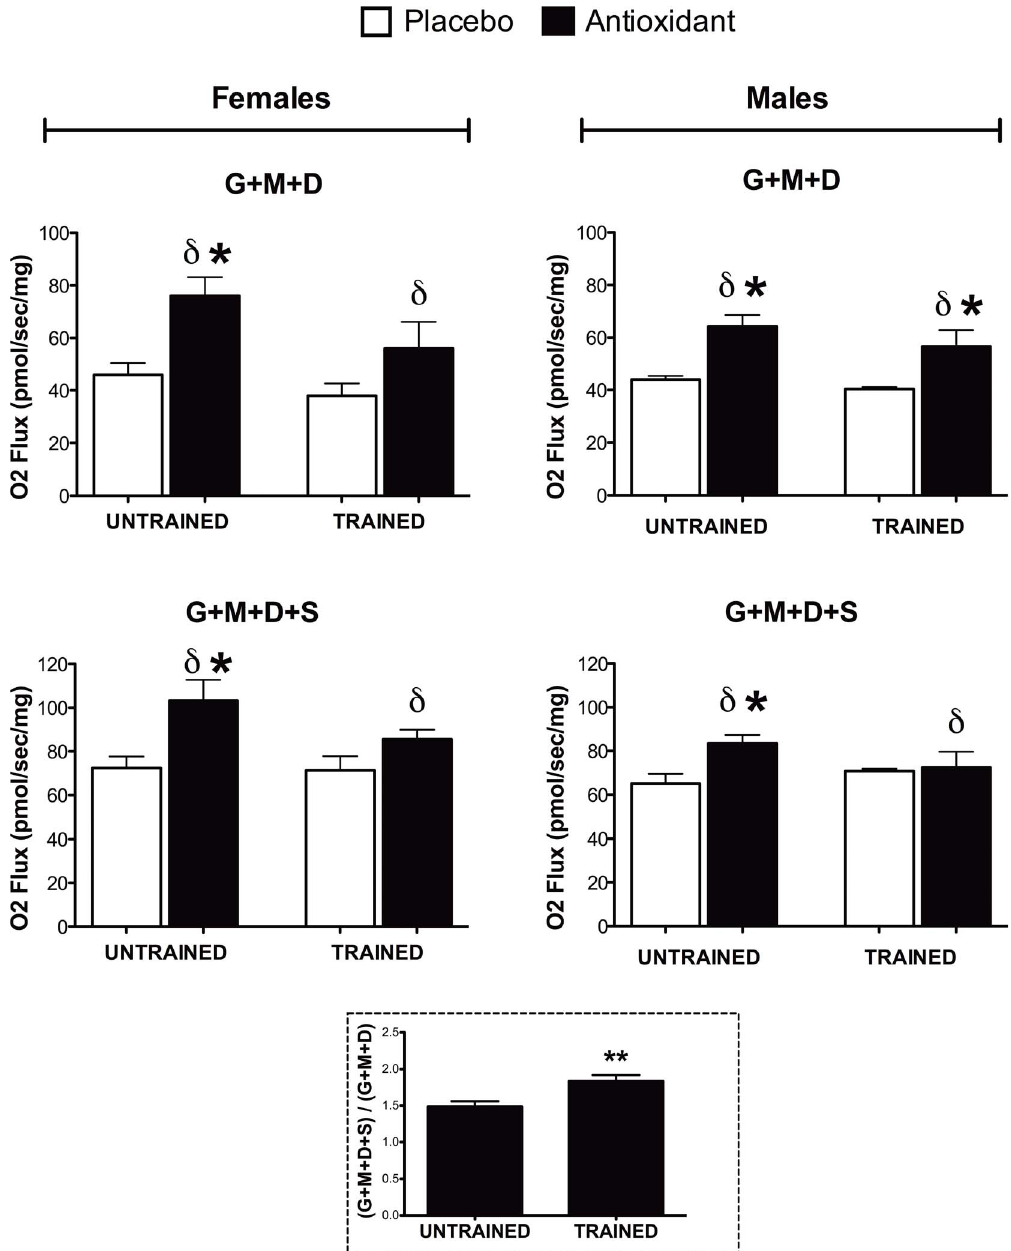
Figure 2. Mitochondrial respiratory capacity. Respiratory capacity was assessed in permeabilized fibers from quadriceps femoris muscle tissue (n=3–4). Maximal coupled respiration was measured in the presence of complex I substrates (glutamate and malate) and ADP (G + M + D, upper panels) followed by addition of the complex II substrate succinate to measure maximal coupled respiration through both complex I + II (G + M + D + S, lower panels). d indicates main effect of antioxidant supplementation (p # 0.05), and post-hoc testing was used to compare antioxidant- and placebo- supplemented groups, * indicates p # 0.05. Effect of training on performance is shown in the inset figure (dotted border) as represented by the ratio of complex I + II respiration (G + M + D + S) to complex I respiration (G + M + D) (unpaired T-Test, ** indicates p ,